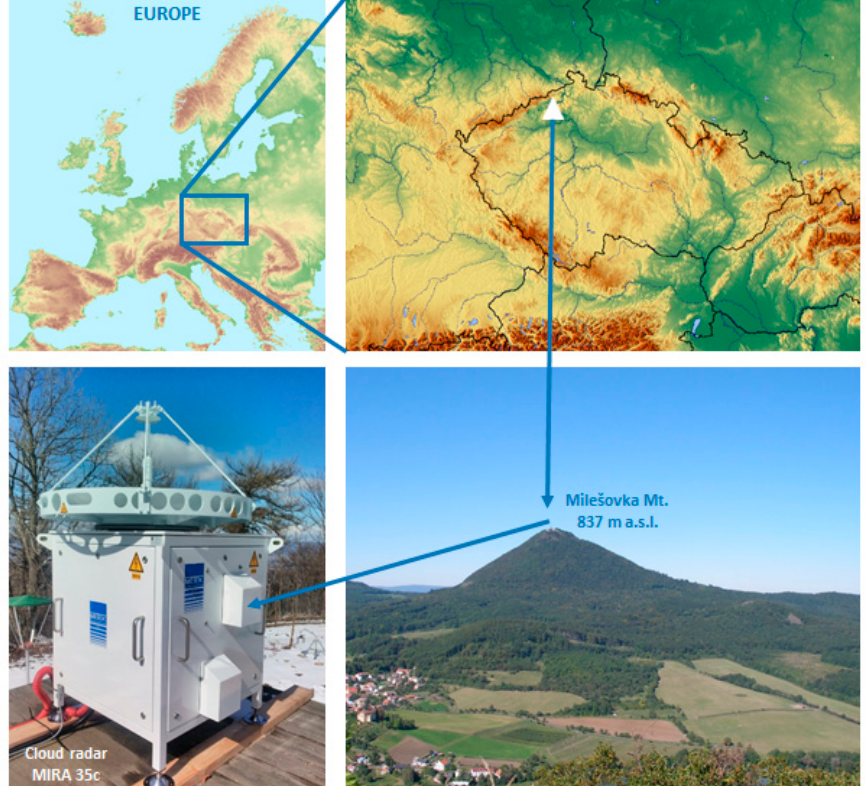
Figure 1. Geographical location of the cloud radar MIRA35c at the Milešovka observatory on top of the Milešovka Mt. (837 m a.s.l.) in Czechia in Central Europe. Source of the topographic maps: (upper left panel) European Environment Agency (https://www.eea.europa.eu/legal/copyright) and (upper right panel) https://maps-for-free.com/. Table 1. Basic technical information on the cloud radar MIRA 35c situated at the Milešovka obser- vatory.